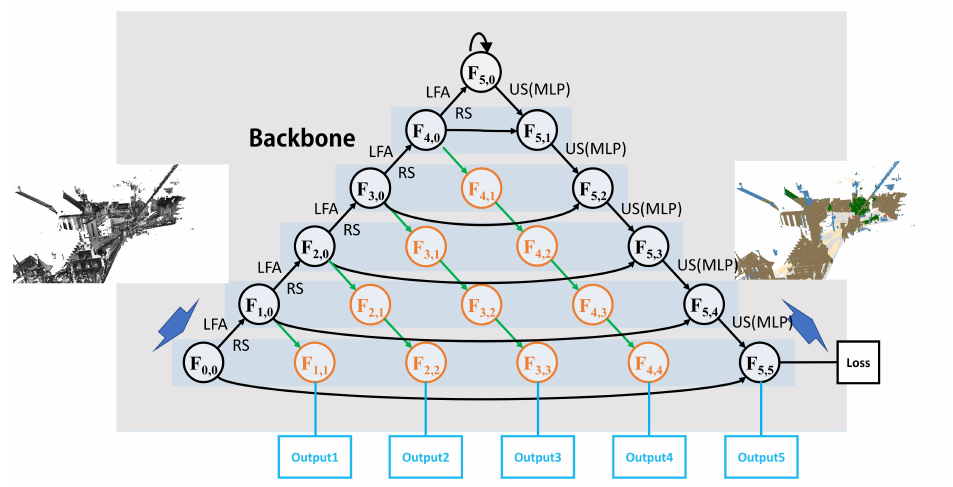
Figure 6. The segmentation results inferenced by MFFRand with different depths; there are outputs in every